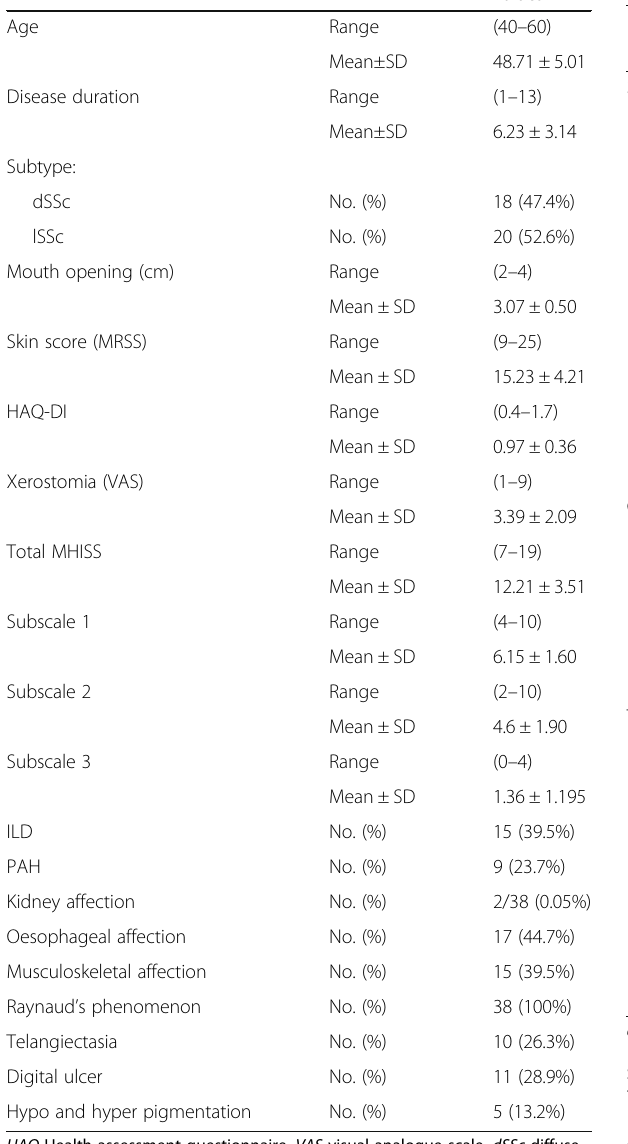
Table 1 Descriptive data of patients Table 2 The mean value of total MHISS in the major clinical manifestations of the disease